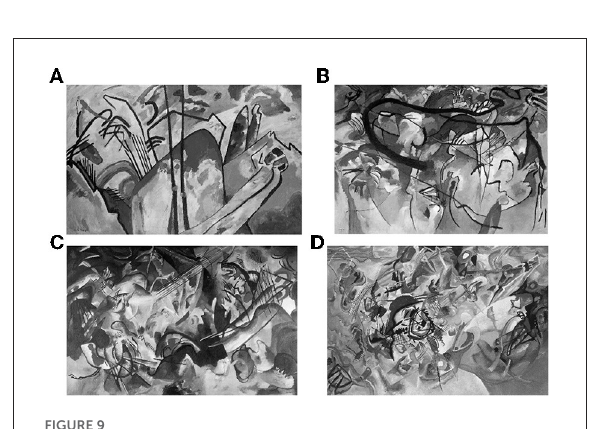
FIGURE9 Experimental materials. Kandinsky’s paintings: (A) Composition IV, 1911, (B) composition V, 1911, (C) composition VI, 1913, and (D) composition VII, 1913.